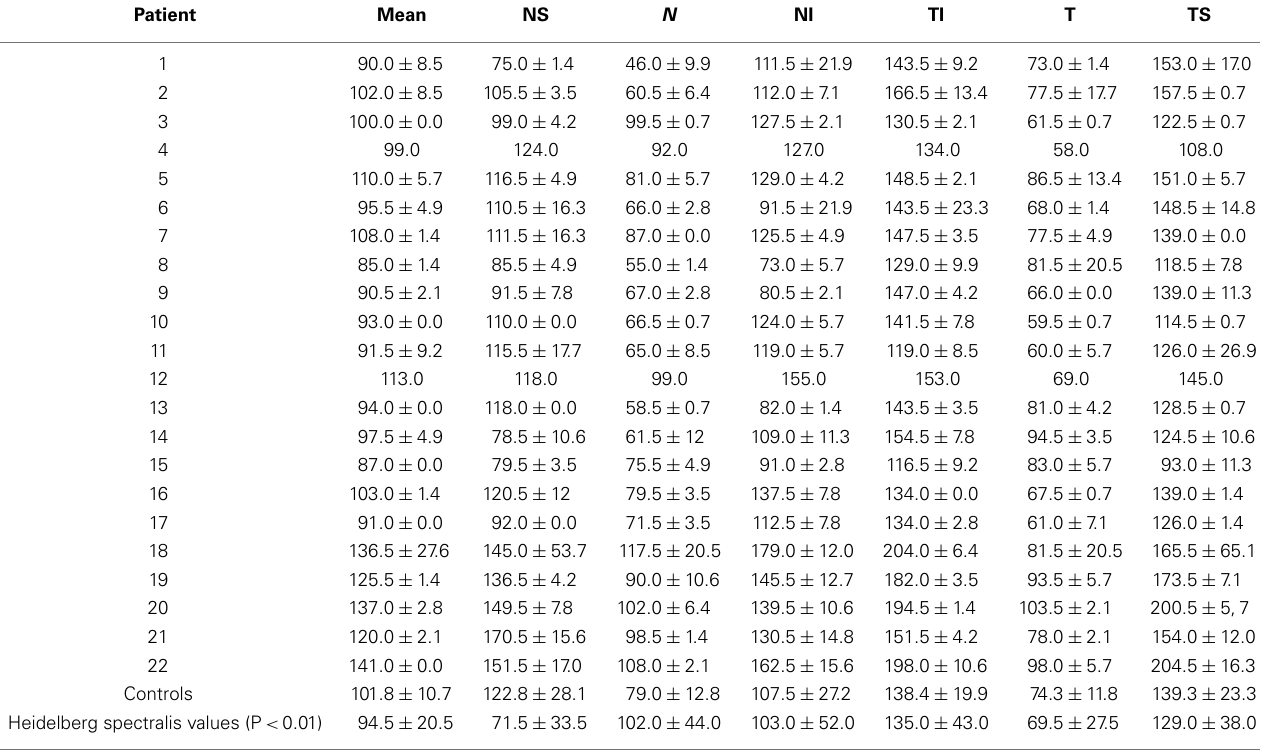
Table 2 | Comparison of the different sectors around the optic disk regarding the retinal nerve fiber layer